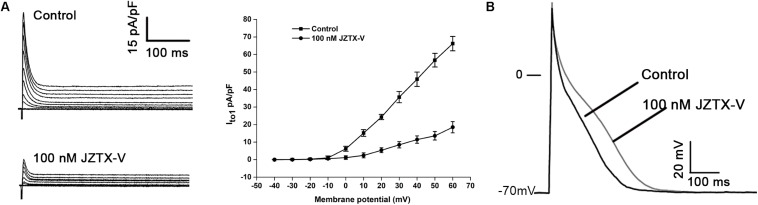
Jingzhaotoxin-V inhibits Ito and extended APD in NRVMs isolated from SD rats. (A) Representative traces of Ito in NRVMs treated with 100 nM JZTX-V. The cell capacitance for the NRVM was 18 ± 3.1 pF. Average I–V relation curves of Ito in NRVMs normalized to cell capacitance treated with 100 nM JZTX-V. (B) Representative traces of action potential recorded in NRVMs treated with 100 nM JZTX-V. For the AP of NRVMs Treatment with the JZTX-V prolonged APD10 from 12 ± 1 ms to 15 ± 1.7 ms, APD50 from 88 ± 6 ms to 109 ± 8 ms, APD90 from 245 ± 7 ms to 309 ± 10 ms.